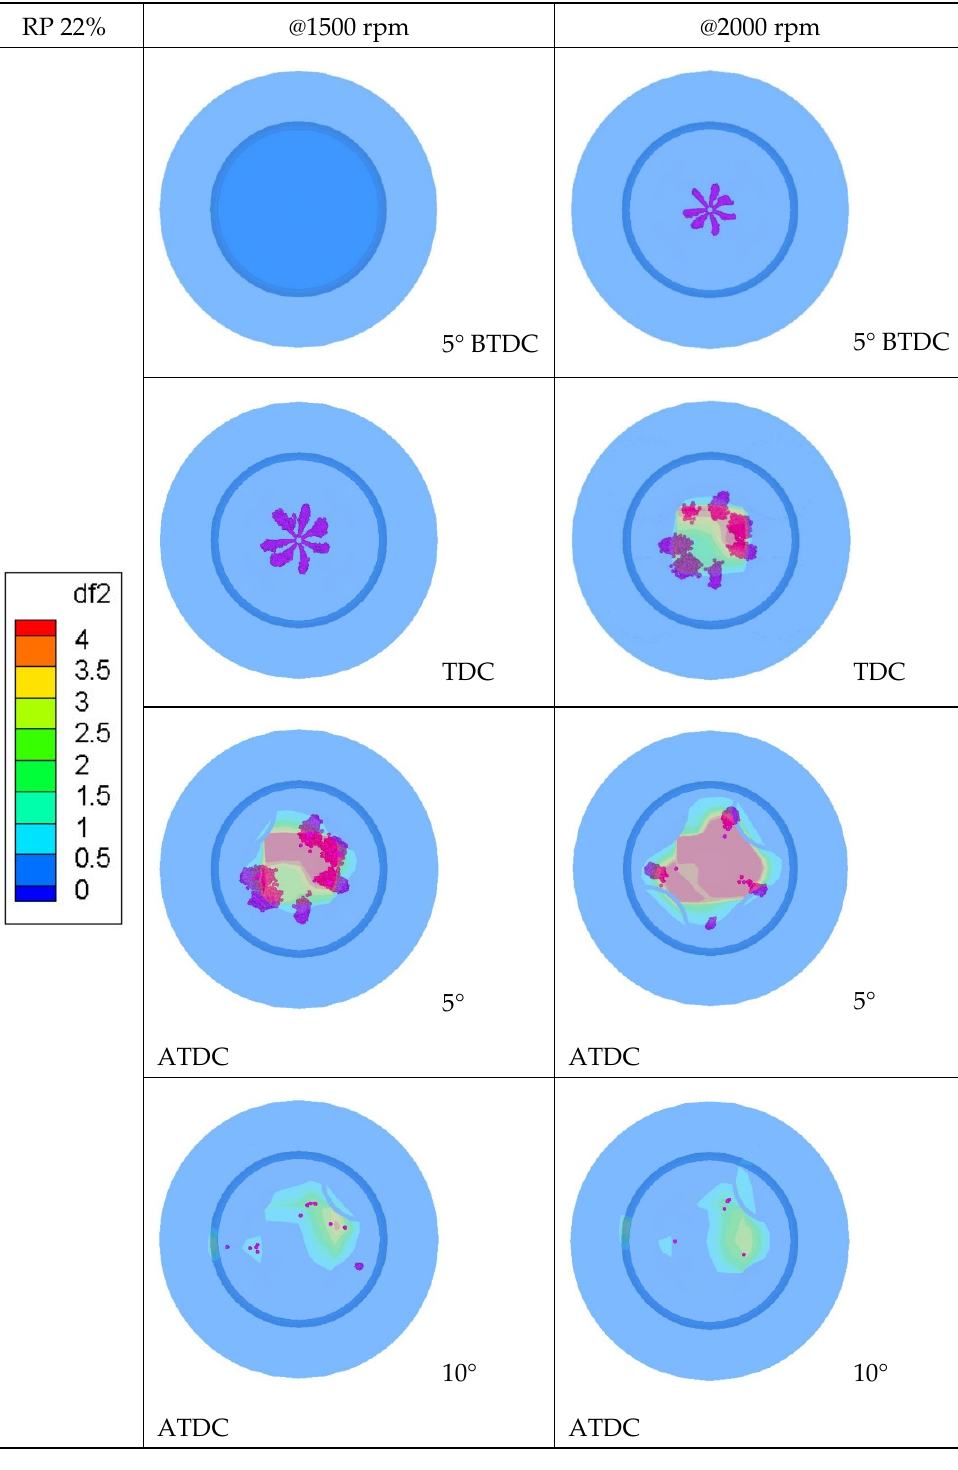
Figure 5. Liquid jet and diesel vapour distributions. Clearly, a different start of injection implies a different correspondence of time at each crank angle. However, at 10 crank angle degree after top dead center (ATDC), almost the same amount of time had passed since the injection start ( ≈ 1.37 ms at 2000 rpm against ≈ 1.48 ms at 1500 rpm), and in both cases, an almost complete vaporization of liquid particles was achieved, and the diesel vapour distributions involved the same areas.